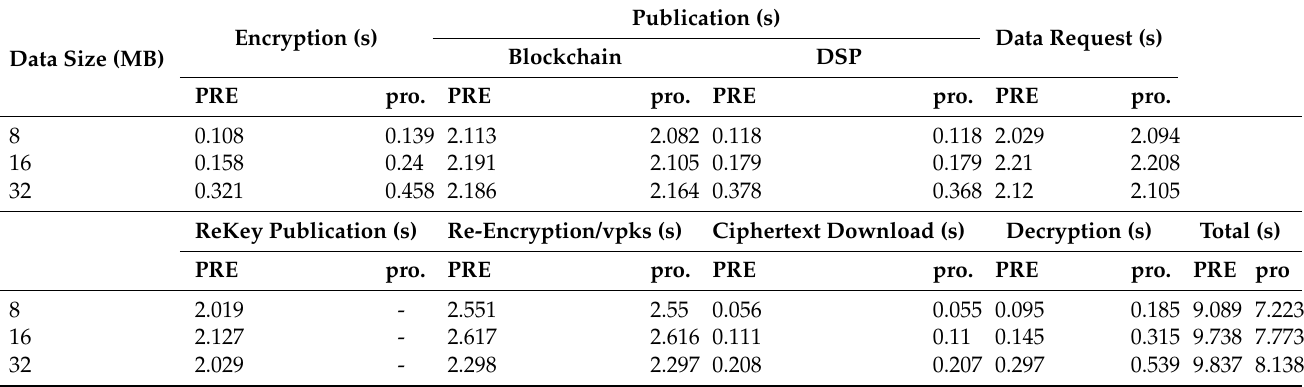
Table 1. A time cost comparison between a PRE-based system and the proposed system. The number of attributes of the ABAC policy is set to 10. The number of organizations in the proposed system is set to 8. The evaluation is repeated 10 times and the average result is